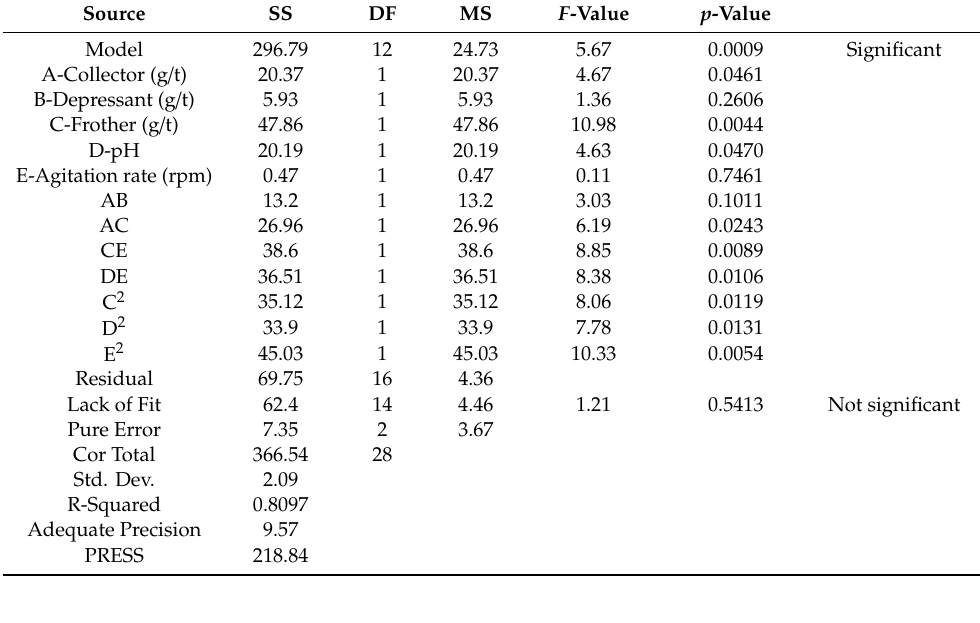
Table 7. ANOVA for response surface modeling (RSM) quadratic model.